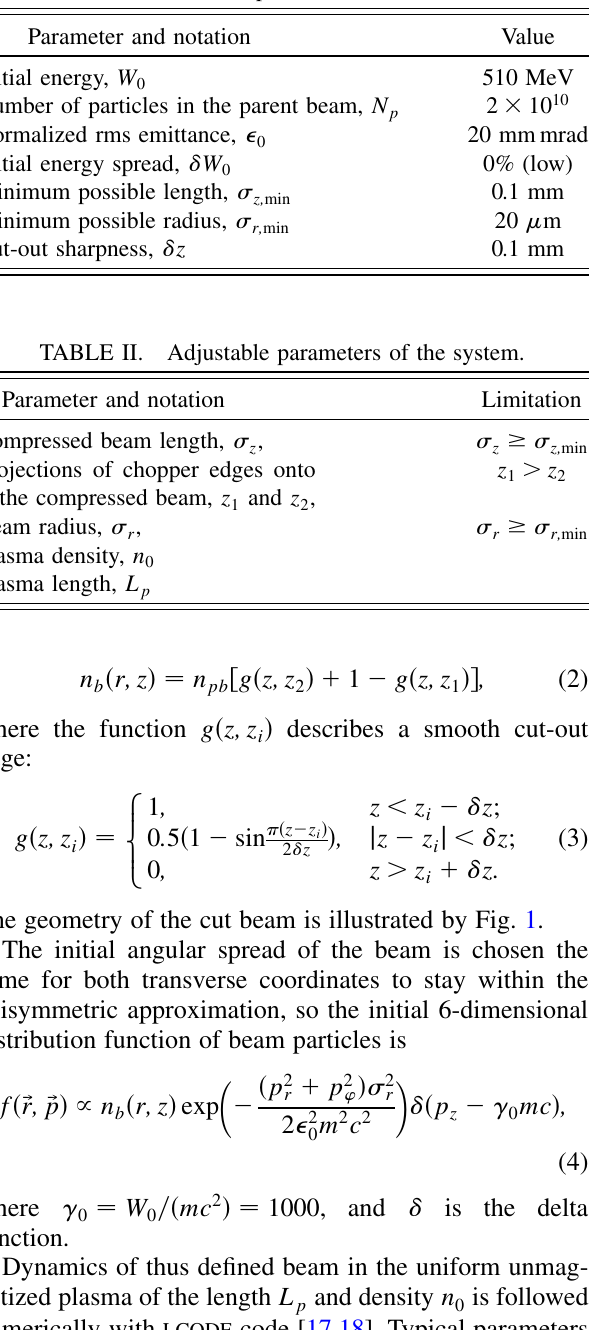
TABLE III. Parameters of a typical LCODE run.